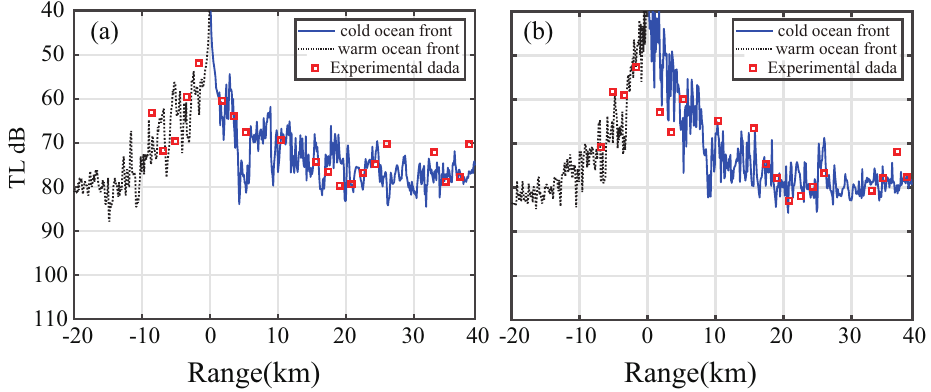
Figure 20. 3-D transmission loss in cold side (blue line), warm side (black dotted line) and experi- mental results with 200 m explosions (red square) in depths of 175 m ( a ), 200 m ( b